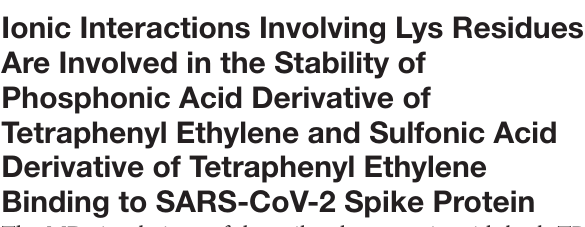
FIGURE 1 | (A) Molecular docking of TPE-P into the active site of the ACE2-binding domain of SARS-CoV-2 spike protein. (B) The average structure of the TPE-P bound ACE2-binding domain of SARS-CoV-2 spike protein extracted from the last 20 ns of total 100 ns of MD simulations. (C) Molecular docking of TPE-S into the active site of the ACE2-binding domain of SARS-CoV-2 spike protein. (D) The average structure of the TPE-S bound ACE2-binding domain of SARS-CoV-2 spike protein extracted from the last 20 ns of total 100 ns of MD simulations. The TPE-P and TPE-S molecules are shown in the stick model, and the amino acid residues are shown in line representation. The hydrogen bonds are shown in broken yellow lines. chain of Arg408 were also involved in the stabilization of the polar head groups of TPE. The triazole ring stabilized by cation- π interaction with Arg403 and the side chain of Tyr453 and Tyr495